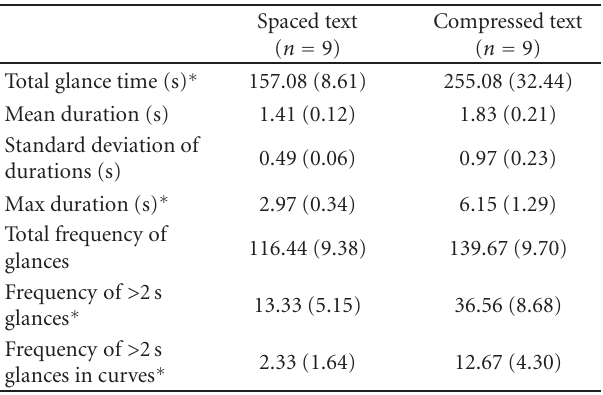
Table 2: Experiment 2: mean values of glance measures to the text display (standard